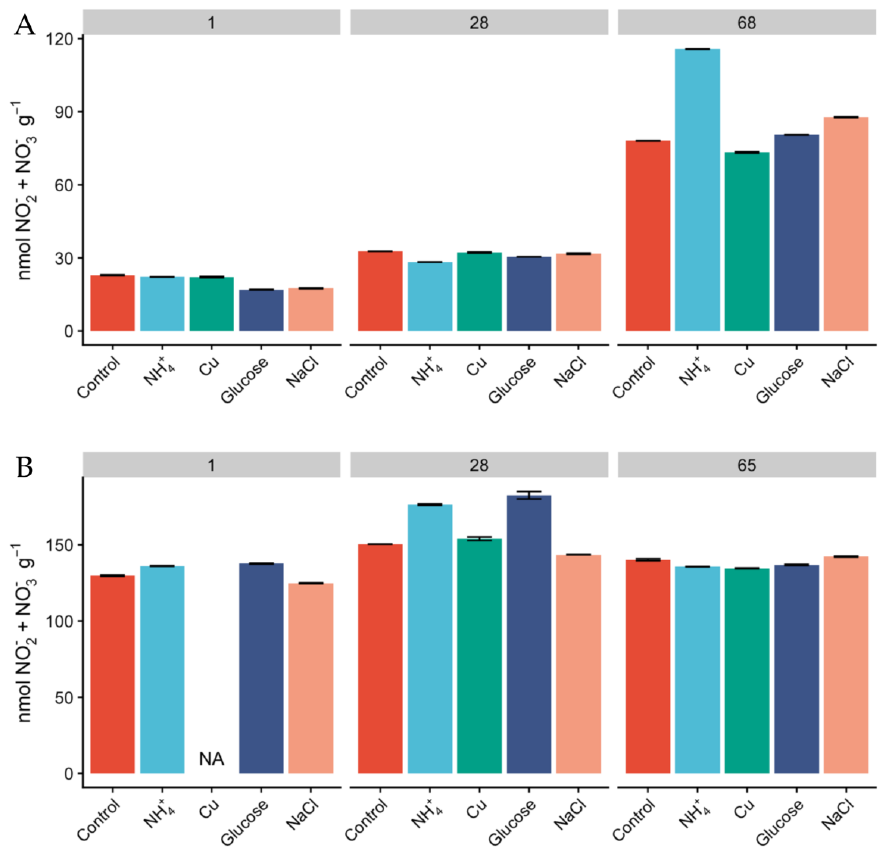
Figure 1. Concentration of NO 2 − + NO 3 − (nmol NO 2 − + NO 3 − g − 1 ) in Miers ( A ) and Beacon ( B ) Valley soils over the course of the experiment, along the different treatments. Columns represent mean values, and bars are the standard deviations of two replicates.